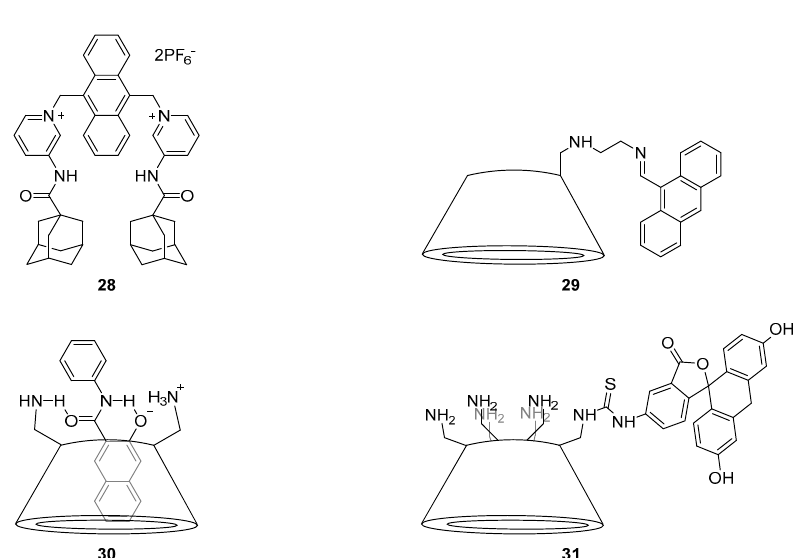
Figure 13. The adamantyl probe 28 gives rise to a strong emission at 500 nm in the presence of H 2 PO 4 − , due to formation an exciplex. This is disrupted when β -CD is added and this emission is quenched [103]. The imine-linked anthracenyl system 29 is a turn-on probe for Pb 2+ , thought to operate via a mechanism involving CT from the nitrogen atoms to the fluorophore [104]. Naphthamide β -CD inclusion complex 30 is a selective and highly sensitive probe for Hg 2+ , which triggers a blue shift in fluorescence emission from 577 to 509 nm and quenching of emission intensity, down to a detection limit of 1 pM [105]. The thiourea-linked fluorescein/ β -CD derivative 31 has been developed as a probe for 2,4,6-trinitrotoluene (TNT), which quenches the 519 nm emission to a detection limit of 20 nM; TNT is believed to react with the primary amines of 31 to form a Meisenheimer complex which is then involved in FRET with the fluorescein component of the probe [106].